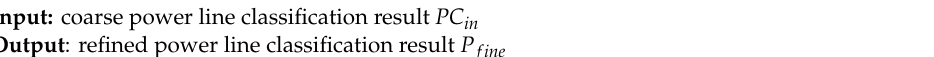
Table 2. Pseudo-code of the refinement process of coarse power line